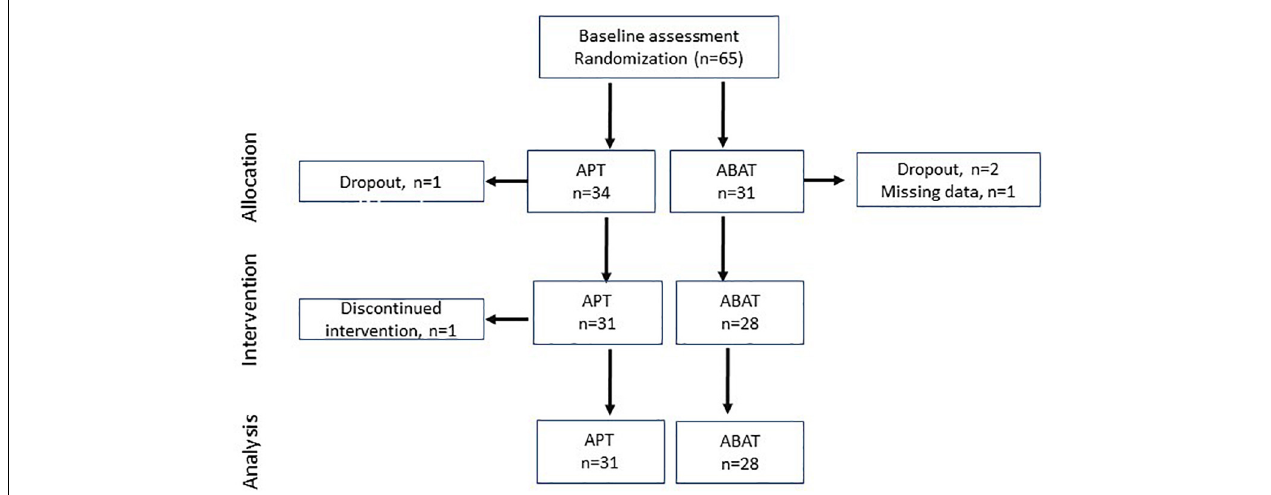
FIGURE 1 | Flowchart of participants in each stage of the trial. APT, Attention Process Training; ABAT, Activity-Based Attention Training.